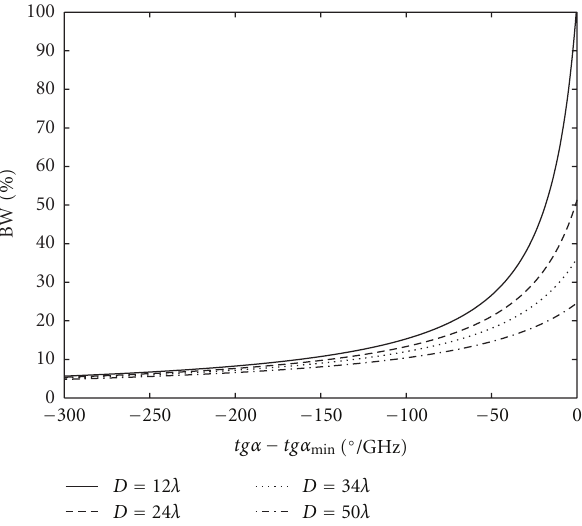
Figure 2: Percent bandwidth versus normalized phase curve slope for di ff erent array diameters ( F/D = 0 . 5).